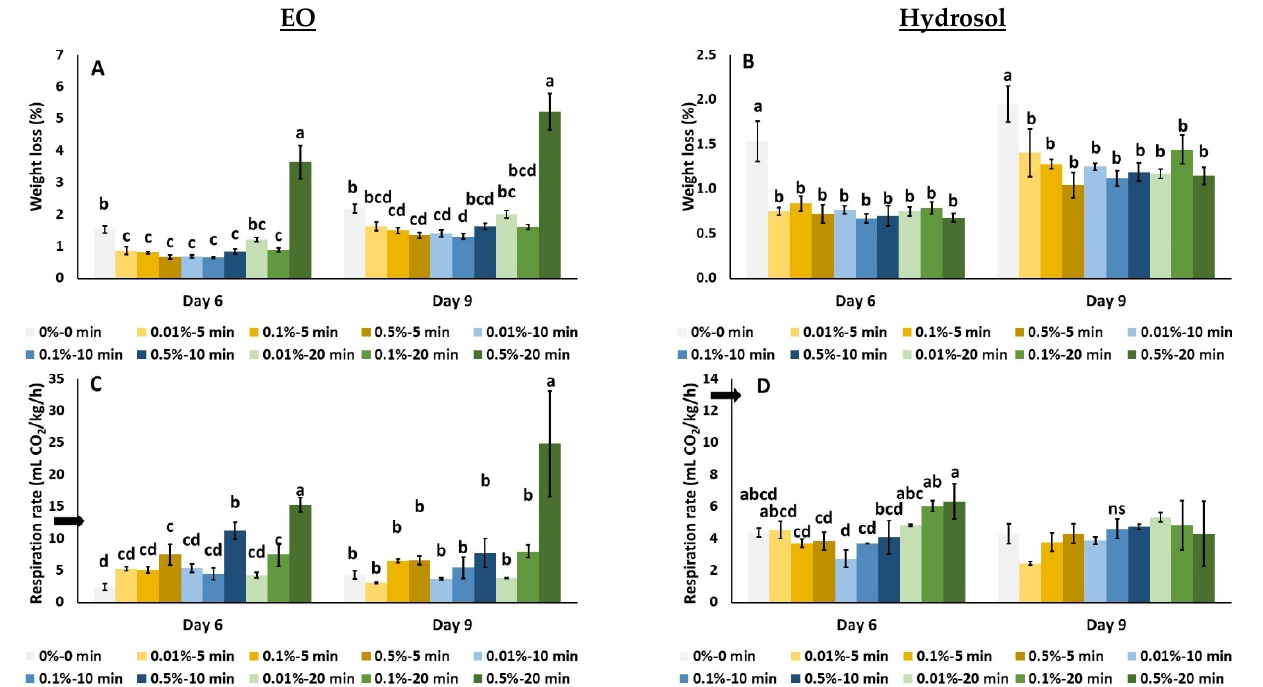
Figure 2. Screening of O. dubium EO ( A , C ) and hydrosol ( B , D ) application effects on weight loss and respiration rate of cucumber fruit stored at 11 ◦ C for 9 days. Bars represent the mean ± standard error of four biological replicates per treatment. Measurements for day 0 refer to the control and are indicated with an arrow. On each day, significant differences ( p < 0.05) among treatments are indicated with different Latin